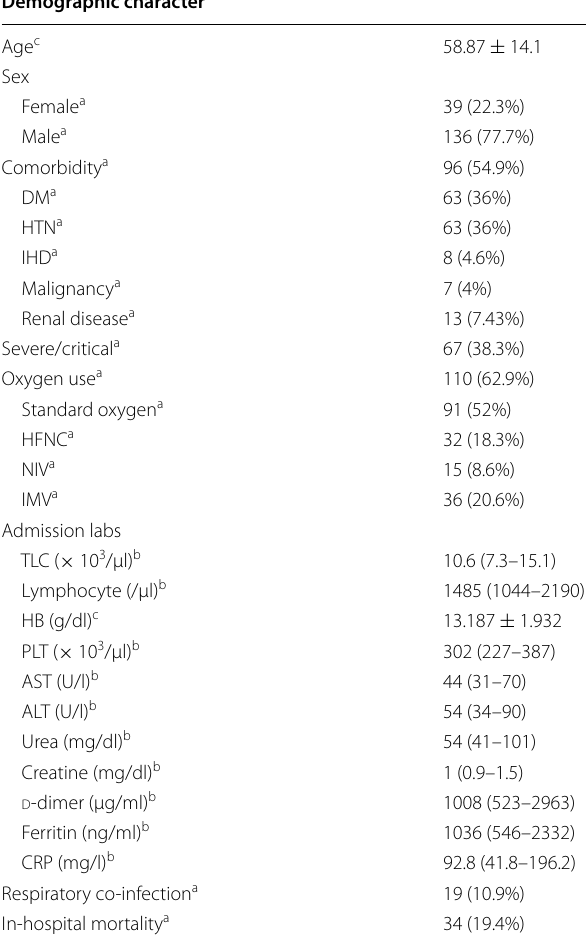
Table 1 Clinical and demographic characteristics and the outcome of patients with